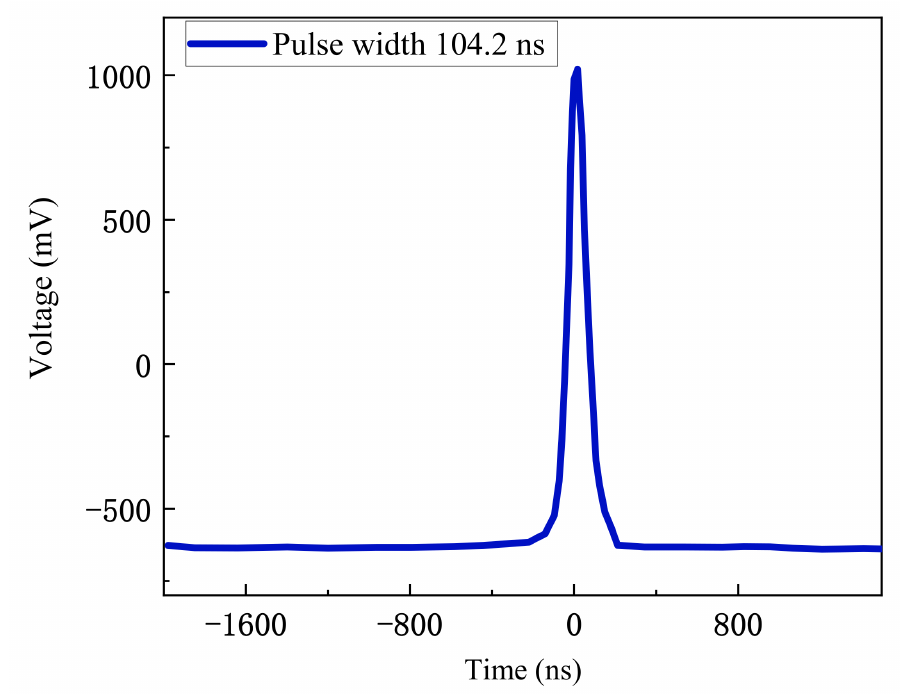
Figure 8. Output pulse width of AO Q-Switched Ho:YAP